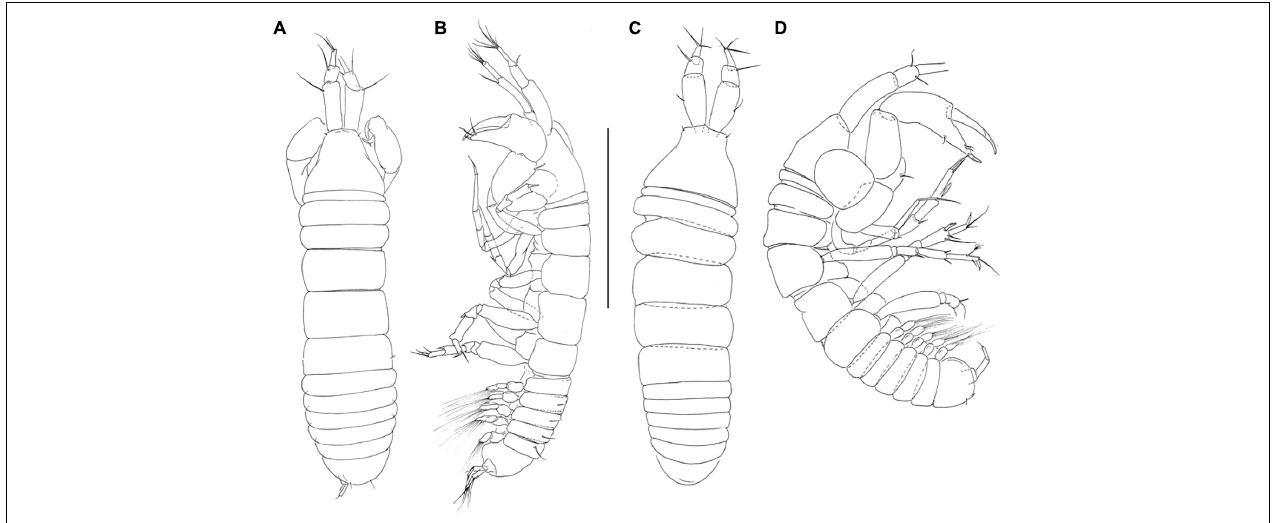
FIGURE 1 | Pseudotanais chardonnayi sp. nov; neuter (J61547), (A) , dorsal; (B) , lateral; juvenile male (J61515), (C) , dorsal, (D) , lateral. Scale line = 1 mm.